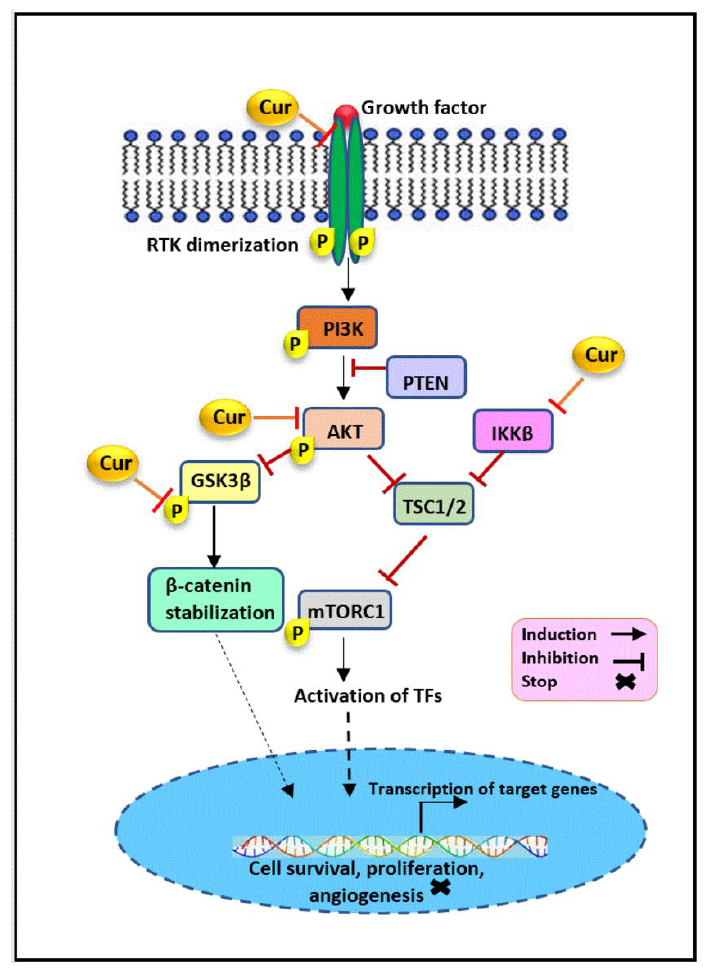
Figure 1. The modulatory effect of curcumin on the PI3K/Akt/mTOR pathway. Curcumin inhibits the PAM signaling pathway through the regulation of its key components. Curcumin downregulates IKKβ, AKT, GSK3β , and HER2 expression, which may facilitate the inhibition of cellular growth, invasion, and metastasis in hormone receptor negative breast cancer. Cur: curcumin, PI3K: phosphatidylinositol-3-kinase, AKT(PKB): protein kinase B, mTORC1: mammalian target of rapamycin complex 1, IKKβ: IκB kinase β, PTEN: phosphatase and tensin homolog, TSC: tuberous sclerosis complex, RTK: receptor tyrosine kinase, GSK3β: glycogen synthase kinase - 3β, TFs: transcription factors.